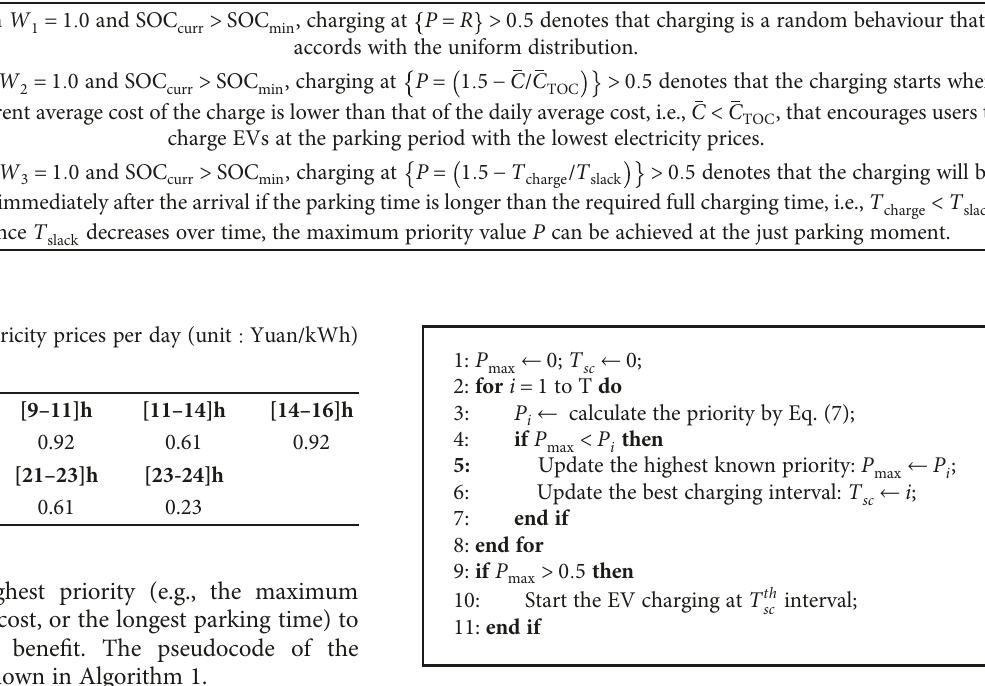
Algorithm 1: The EV charging